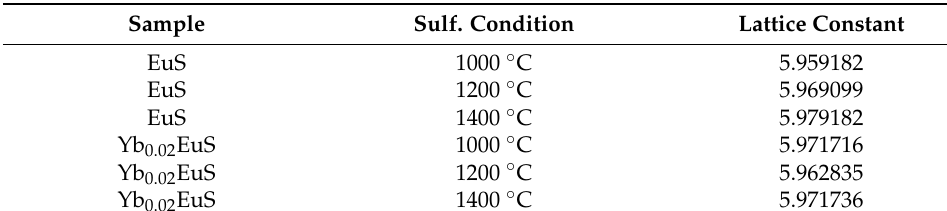
Table 1. Sulfurization conditions, sintering conditions, and lattice parameters of sintered EuS and Yb-doped EuS. Sample Sulf. Condition Lattice Constant